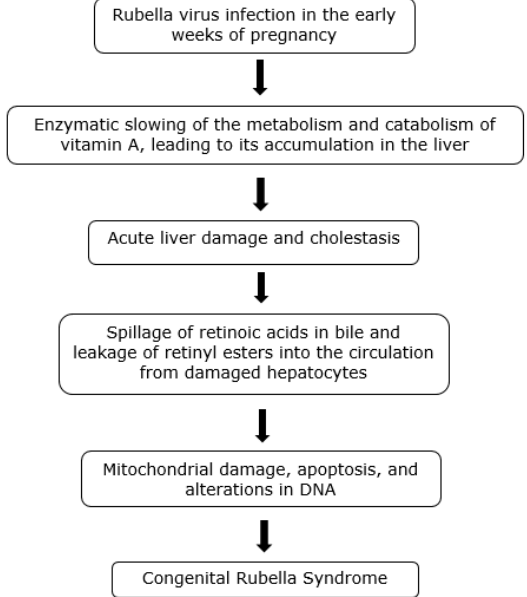
Figure 2. Authors’ proposed pathogenesis of the Congenital Rubella Syndrome.